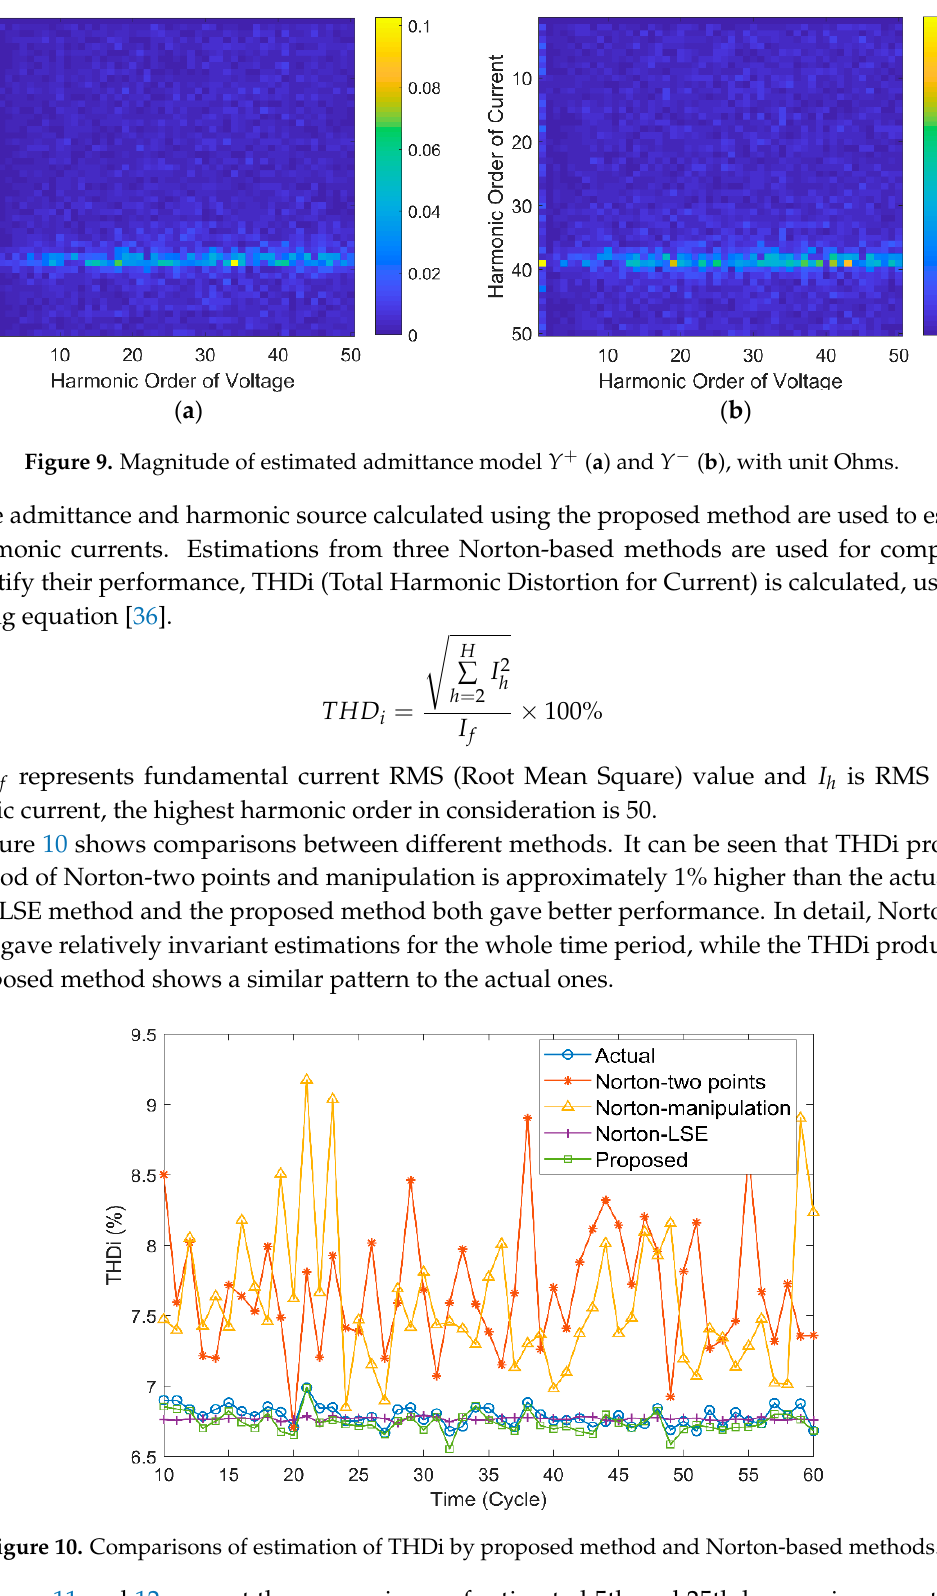
+ − ( a ) and Y ( b ), with unit Ohms.